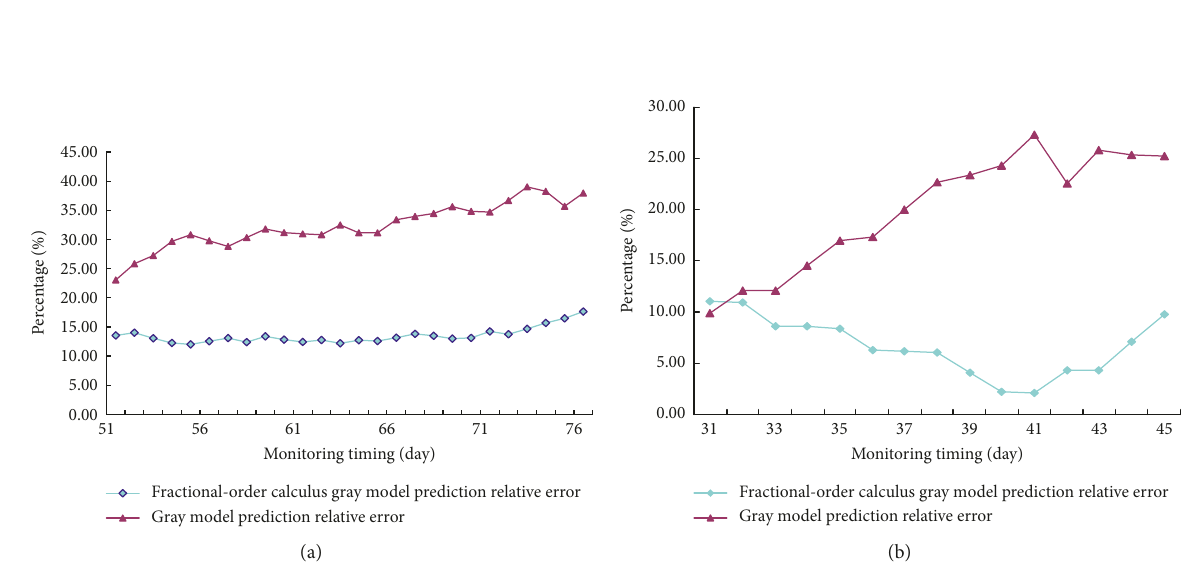
Figure 5: (a) JC-1 and (b) JC-2 monitoring point deformation prediction relative errors.